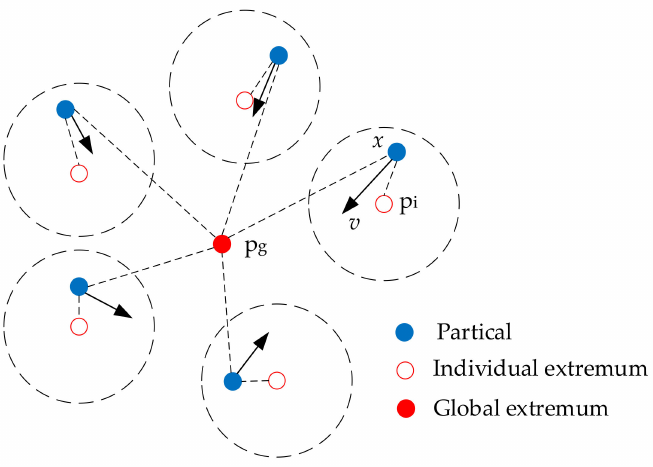
Figure 1. Schematic diagram of particle